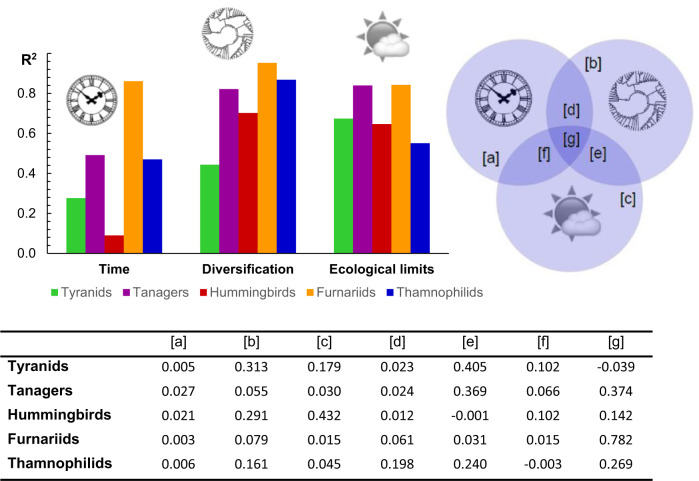
Partitioning the variation in elevational richness. The relative effects of time, diversification rates, and ecological limits (top panel) indicate that elevational changes in richness are best explained by climate and productivity (\documentclass[12pt]{minimal}
\usepackage{amsmath}
\usepackage{wasysym}
\usepackage{amsfonts}
\usepackage{amssymb}
\usepackage{amsbsy}
\usepackage{upgreek}
\usepackage{mathrsfs}
\setlength{\oddsidemargin}{-69pt}
\begin{document}
}{}$R^{2} \approx 0.70, P < 0.001$\end{document}). Detailed results, however (bottom panel), reveal that the three classes of explanations overlap significantly in their effects. The notation in the diagram (top right) corresponds with table columns (bottom), detailing the variation explained by the different combinations of effects.